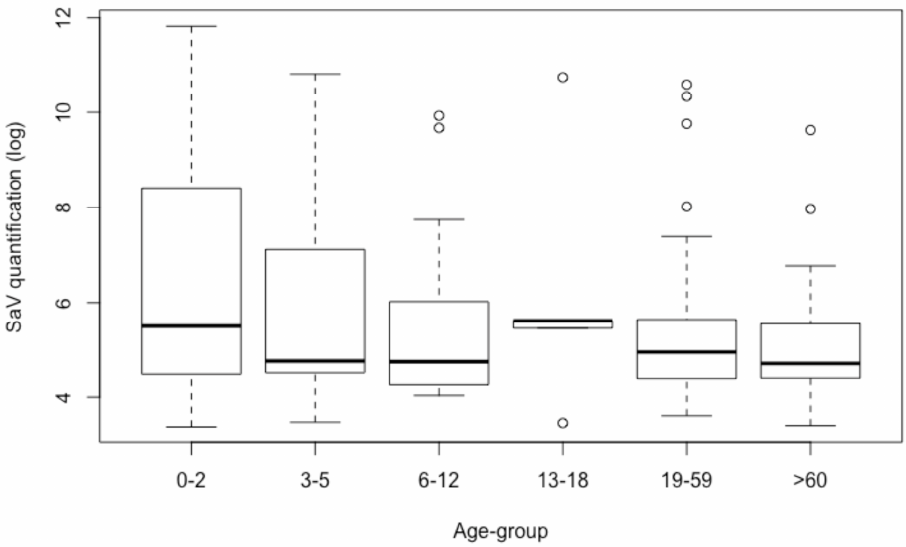
Figure 4. Boxplot showing logarithmic SaV quantifications for each age group.